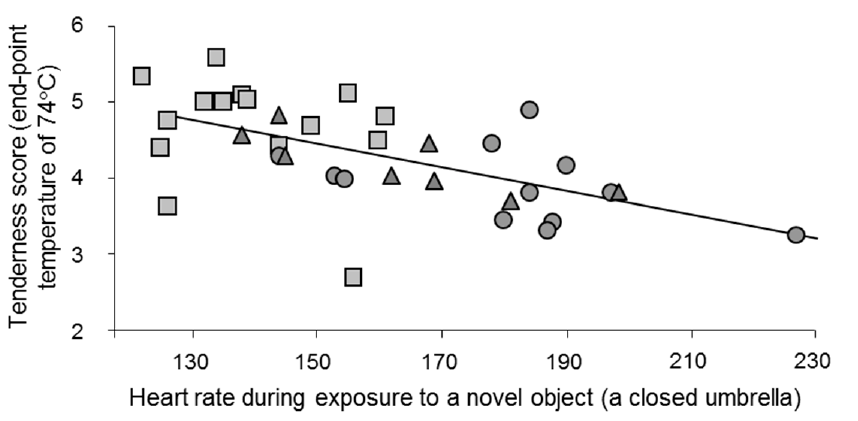
Figure 5. The faster the heart rate response of young bulls of different breeds when exposed to a novel object (a closed umbrella) during a test during the rearing period, the less tender their meat ( r = − 0.59; p = 0.01). The tenderness scale goes from 0 (tough) to 10 (tender). Squares, circles and triangles represent Angus, Blonde d’Aquitaine and Limousine bulls, respectively. A faster heart response is indicative of increased fear reactions in unfamiliar situations. Heart rate data are from [38] and meat quality data from [88,89], who worked on the same animals. Adapted from [61], with permission from INRAE,